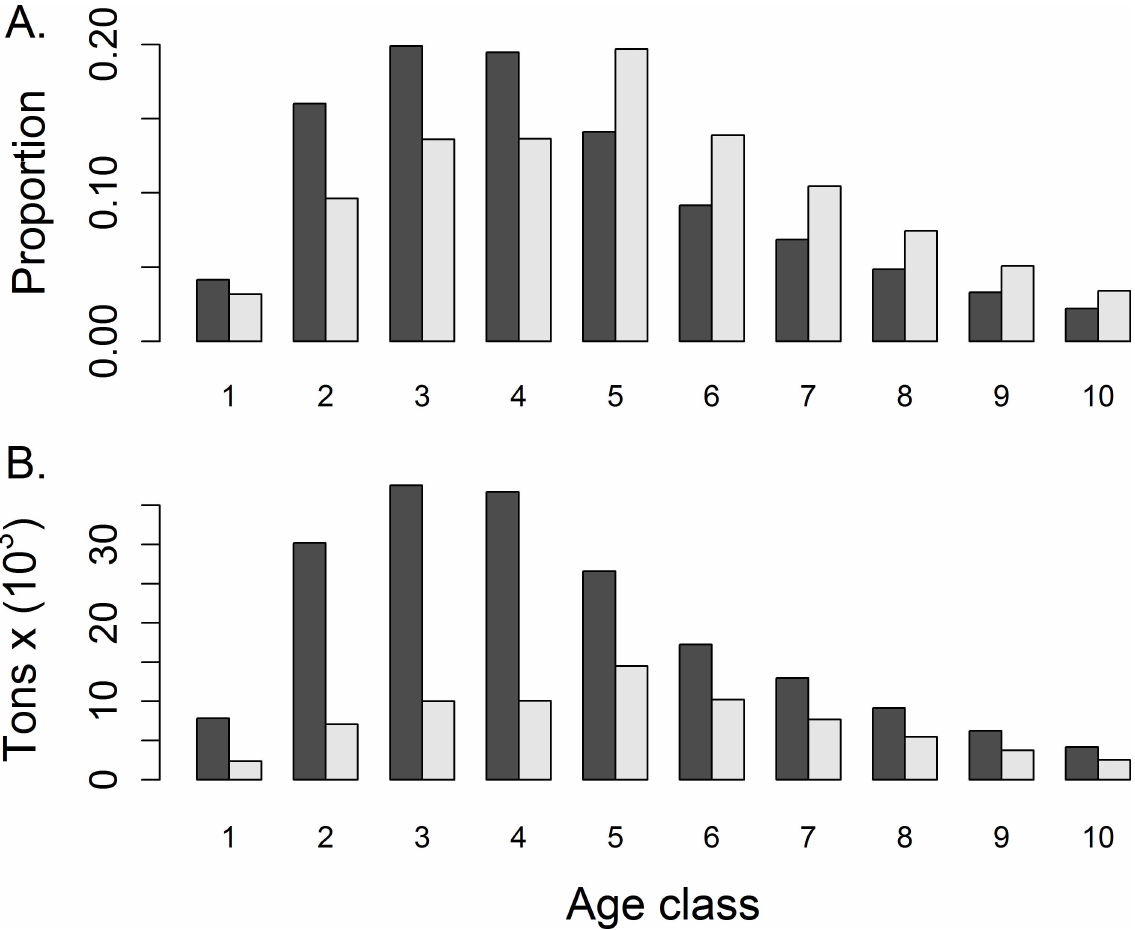
Fig 4. Differences in age composition for the large demersal fish guild. No oil (dark gray); oiled (light gray). Data represent October 2010 for heavily impacted polygons. Represents oil simulation [K1000 β 363]. A) Relative proportion, B) absolute biomass.